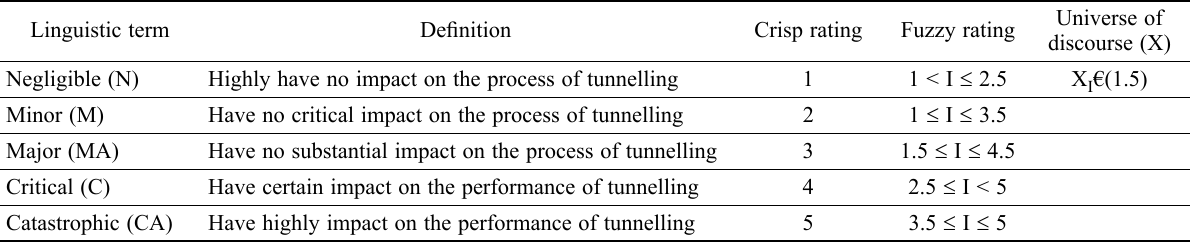
Table 2. Definition of impact levels